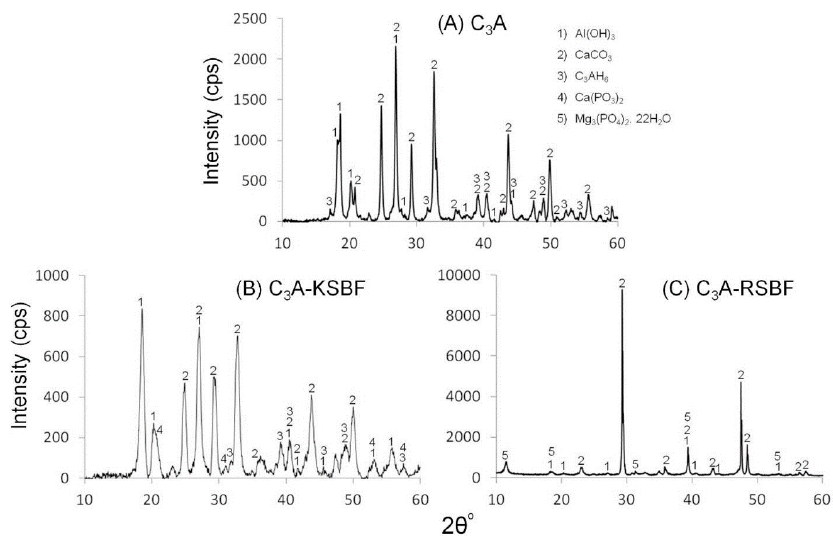
Figure 7. XRD patterns of C A (A) before immersion in SBF; (B) after 7 days in KSBF and (C) after 7 days in 3